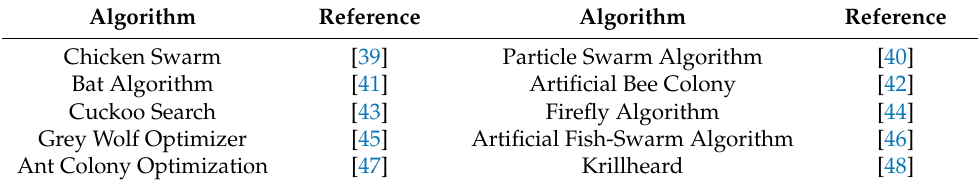
Table 3. References for a detailed study.